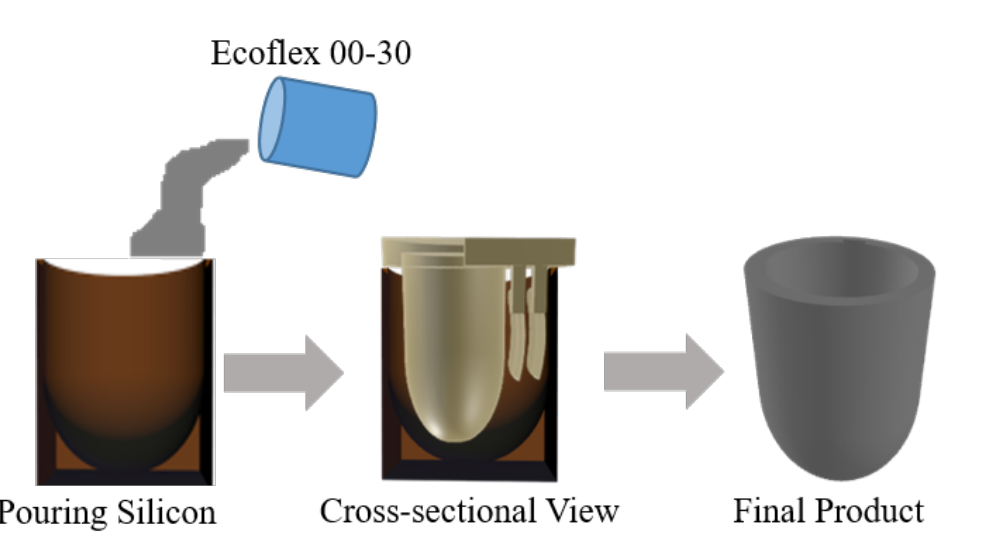
Figure 1. Molding process to manufacture the actuator.